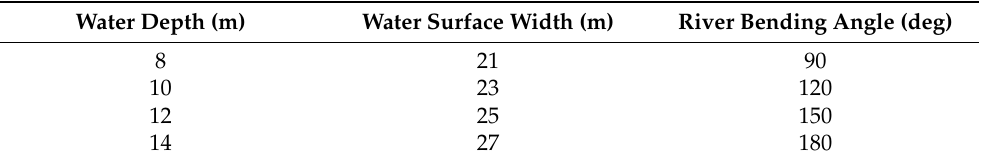
Table 2. Value of river channel characteristic